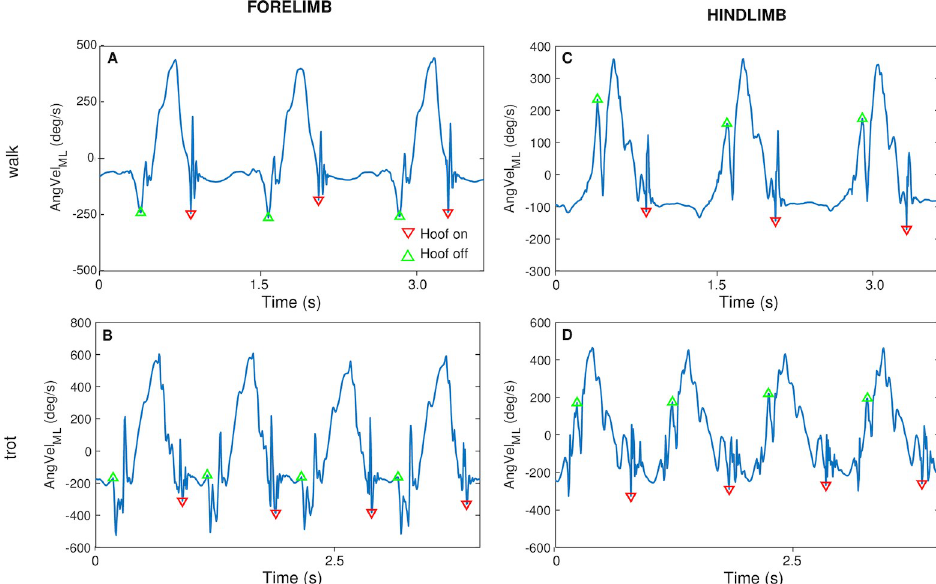
Fig 4. Illustration of M3 c . The implementation of M3 c for each limb and gait is illustrated; hoof-on events are indicated by down triangles and hoof-off by up triangles.